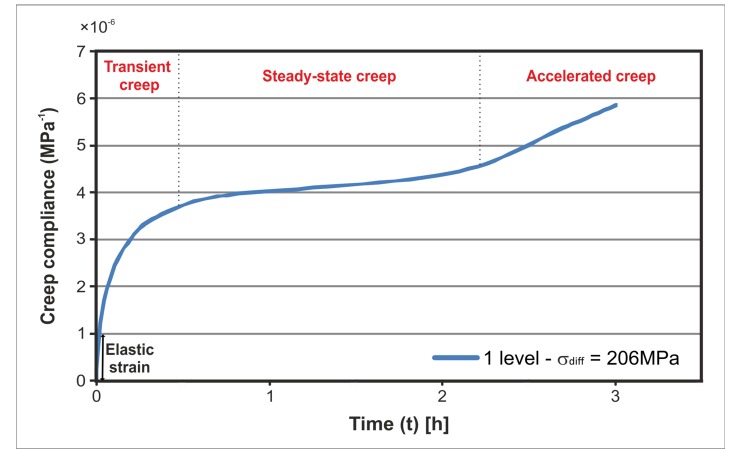
Figure 13. Brittle creep compliance (sample W-305-B).